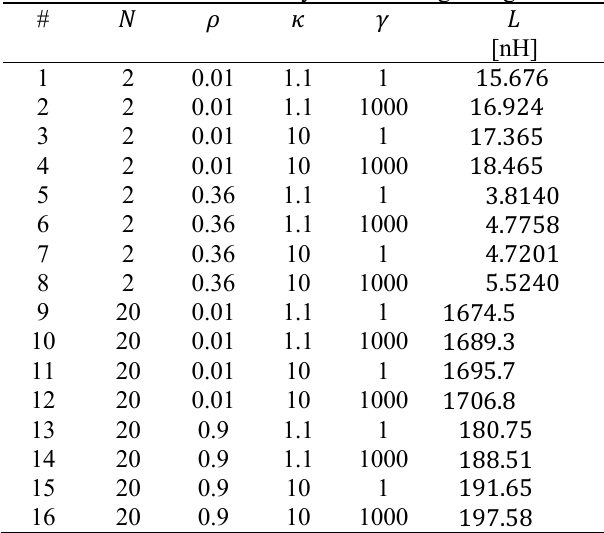
Table 1: The precise inductances 𝐿 for the 16 combinations of the dimensionless parameters 𝑁 , 𝜌 , 𝜅 , and 𝛾 , for 𝐴 = 1 mm and the layout according to Fig.